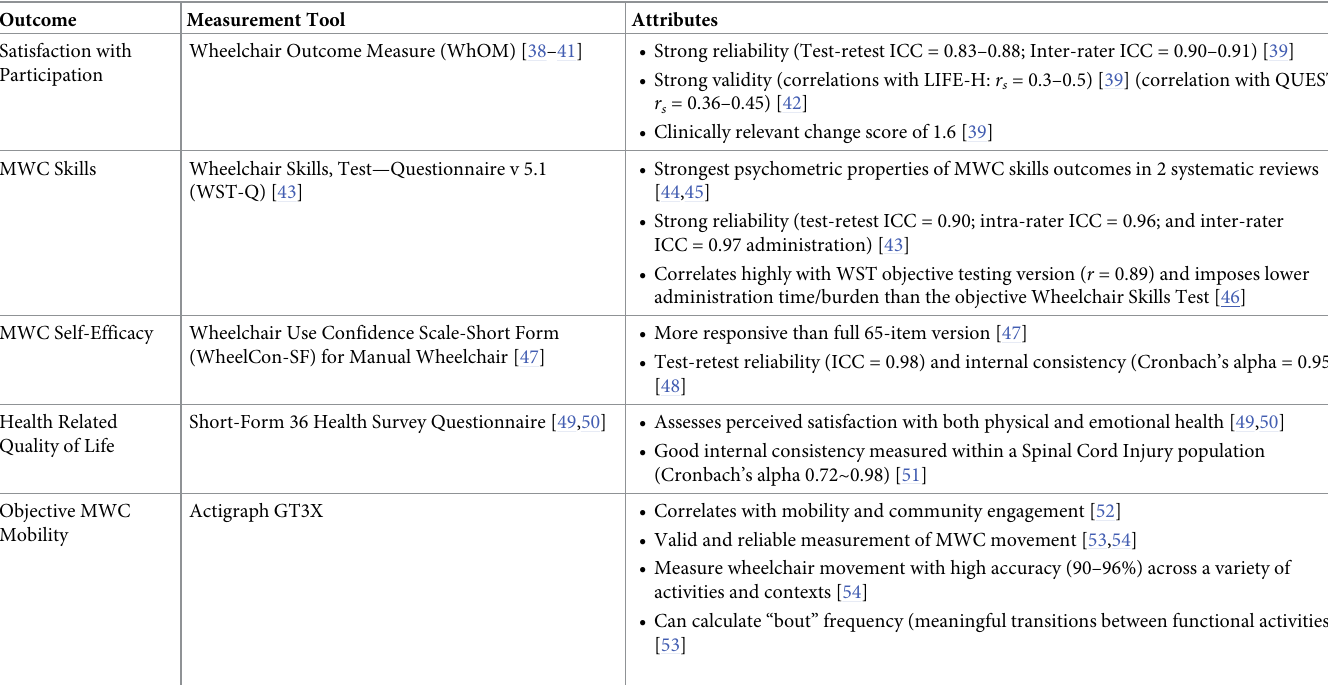
Table 2. Measurement properties of outcome